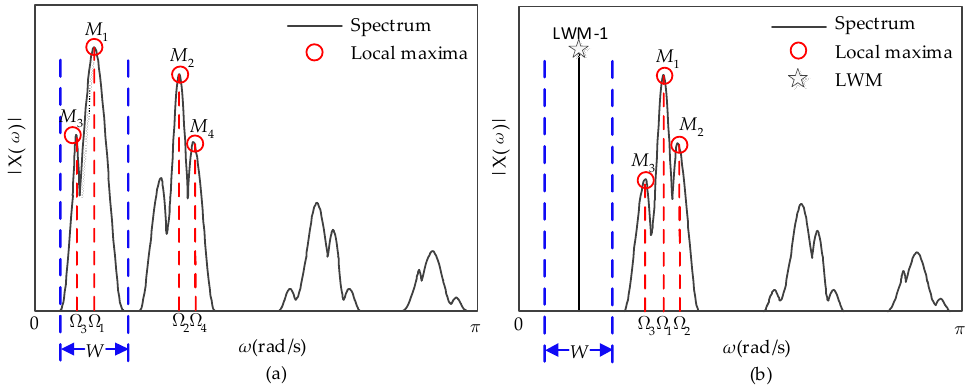
Figure 3. The detection process of the first LWM. ( a ) Detect the four local maxima and determine the window. (Red circles are the local maxima; blue dashed lines are the boundaries of the window.); ( b ) zero the amplitude in the window, obtain the first LWM which is denoted by pentagram, and redetect the other three local maxima which are denoted by the red circles.